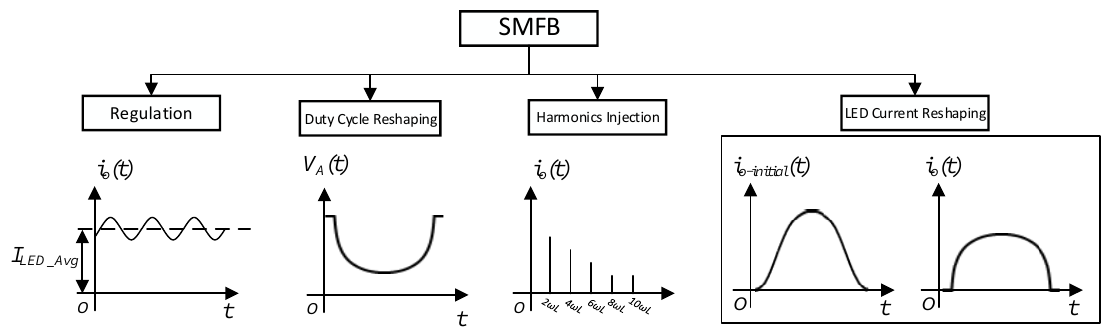
Figure 12. Single Multifunction Block (SMFB) functions.